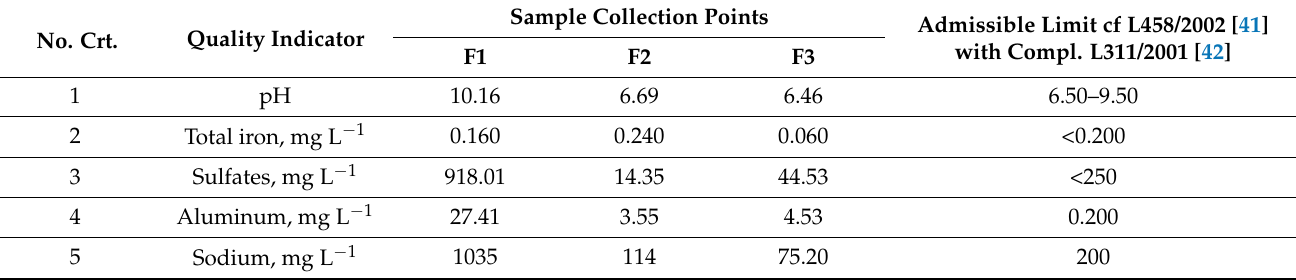
Table 5. The influence of the C0 sludge dump on the samples collected from the groundwater.